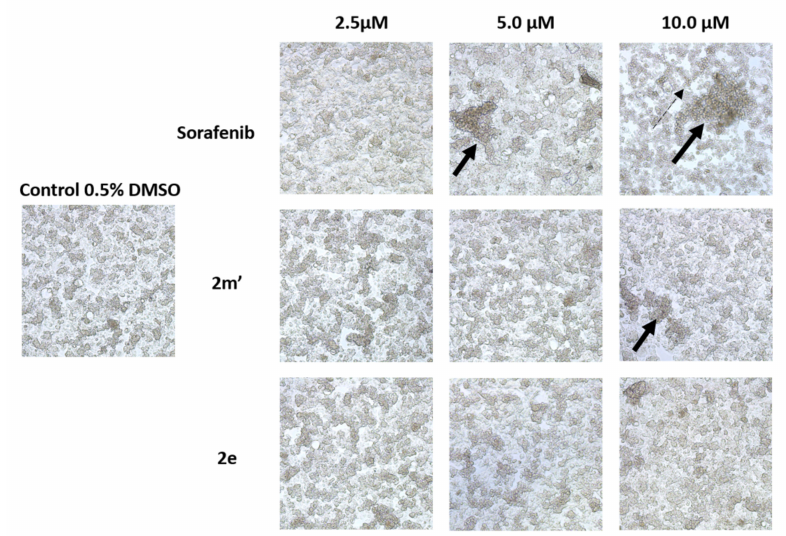
Figure 7. The cell morphology of HepG2 cells treated with different concentrations of compounds 2m’ and 2e at 48 h, compared with 0.5% DMSO as a control and Sorafenib. The bold arrows show morphological changes with cell shrinkage and the dashed arrow shows cells smaller in